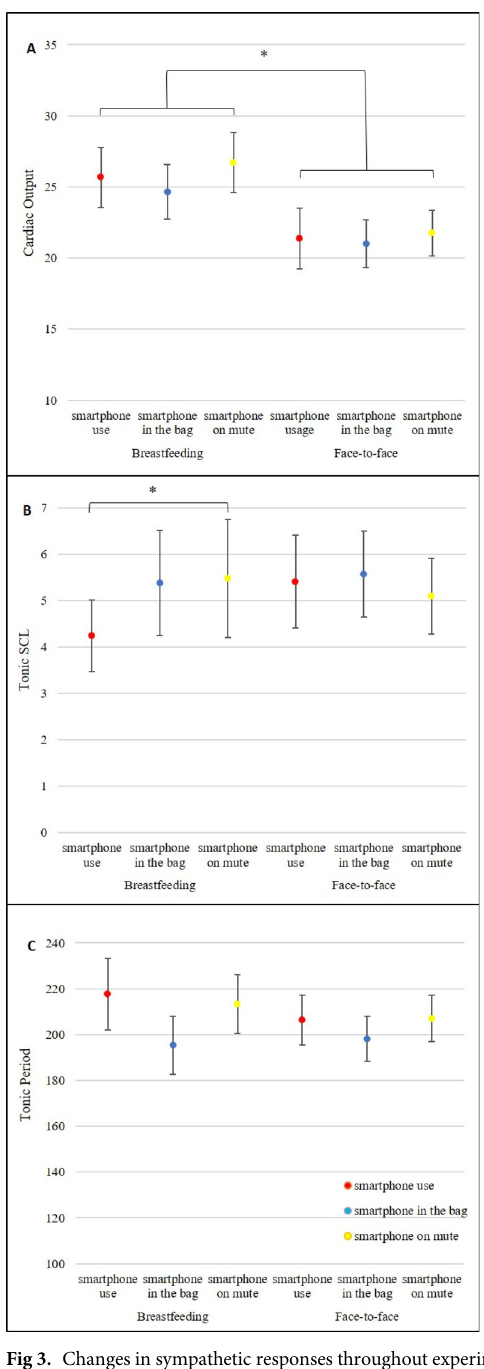
Fig 3. Changes in sympathetic responses throughout experiment conditions and phases: cardiac output (A), tonic SCL (B) and tonic period (C). Experimental phases: breastfeeding and face-to-face interaction. Experimental conditions (5 minutes each): Smartphone use, smartphone in bag (sound on) and smartphone on mute (in bag). (A) Cardiac output (CO; in liters per condition). Significance for experimental phases. � p < .05. (B) Tonic SCL = Tonic Skin Conductance Level, measured in microSiemens. Significance for the experimental conditions � p = .05. (C) Tonic period = time (in seconds) without skin conductance responses.